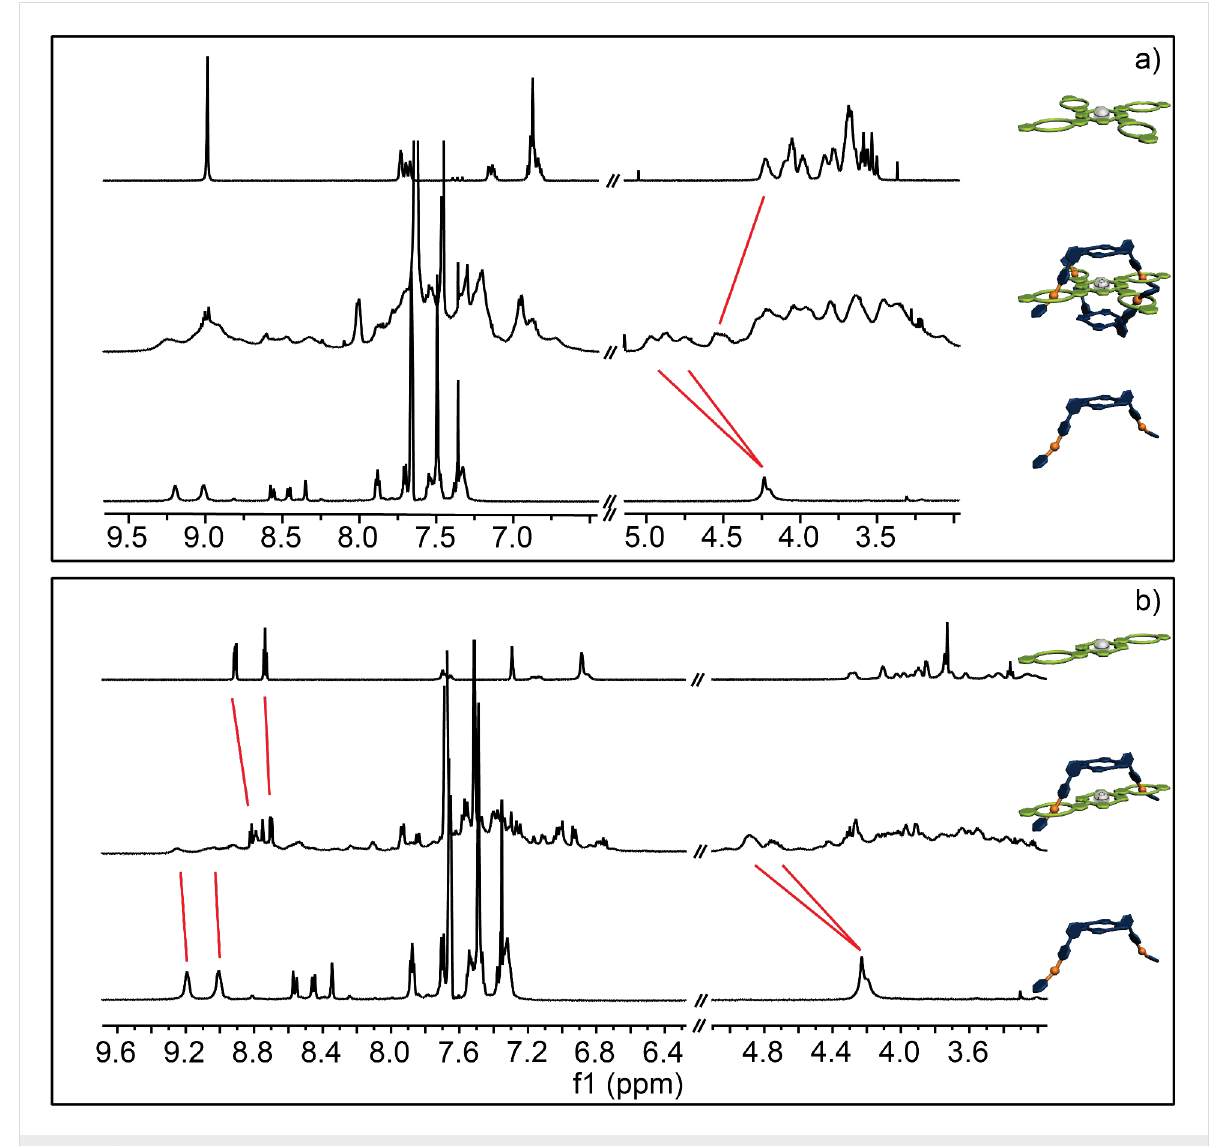
Figure 7: 1 H NMR (500 MHz, 298 K, CD 2 Cl 2 , 1 mM) of a) C4 (top), A2 2 @ C4 (middle) and A2 (bottom); b) C2 (top), A2 @ C2 (middle) and A2 (bottom). Disappearance and shift of the signals (red lines) suggest complexation. Due to the presence of a complex stereoisomeric mixture only qualitative information of the complexation is